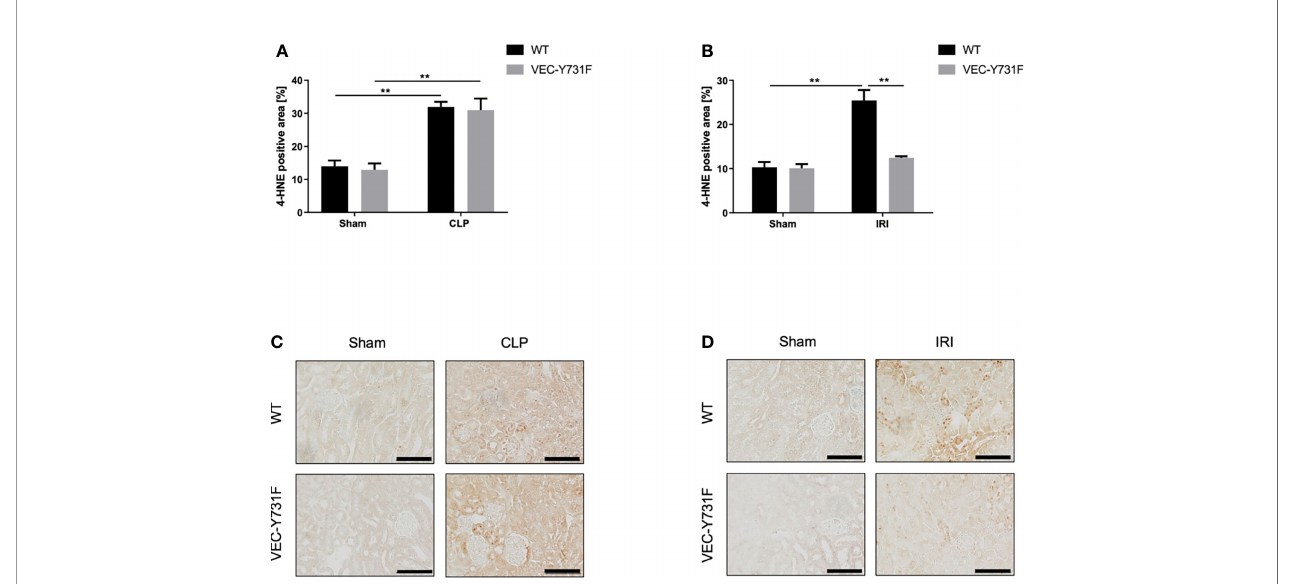
FIGURE 3 | ROS levels in kidney tissue are decreased in mice with impaired neutrophil recruitment only following IRI-induced AKI, but not CLP-induced AKI. AKI in WT and VEC-Y731F mice was induced either by CLP or IRI. 24 hours after AKI-induction renal cortical tissue sections were excised, fi xed in formaldehyde, embedded in paraf fi n and processed for immunohistochemistry staining against 4-HNE to quantify tissue ROS levels. The histological analysis was performed from at least 25 high-power fi elds per kidney from WT and VEC-Y731F mice after CLP (A) or IRI (B) surgery and the 4-HNE-positive tissue area was quanti fi ed by computational image analysis. Exemplary histological images of 4-HNE staining from WT and VEC-Y731F mice after CLP (C) or IRI (D) surgery (n = 3). Data are mean ± SEM. **p < 0.01. Scale bar: 100